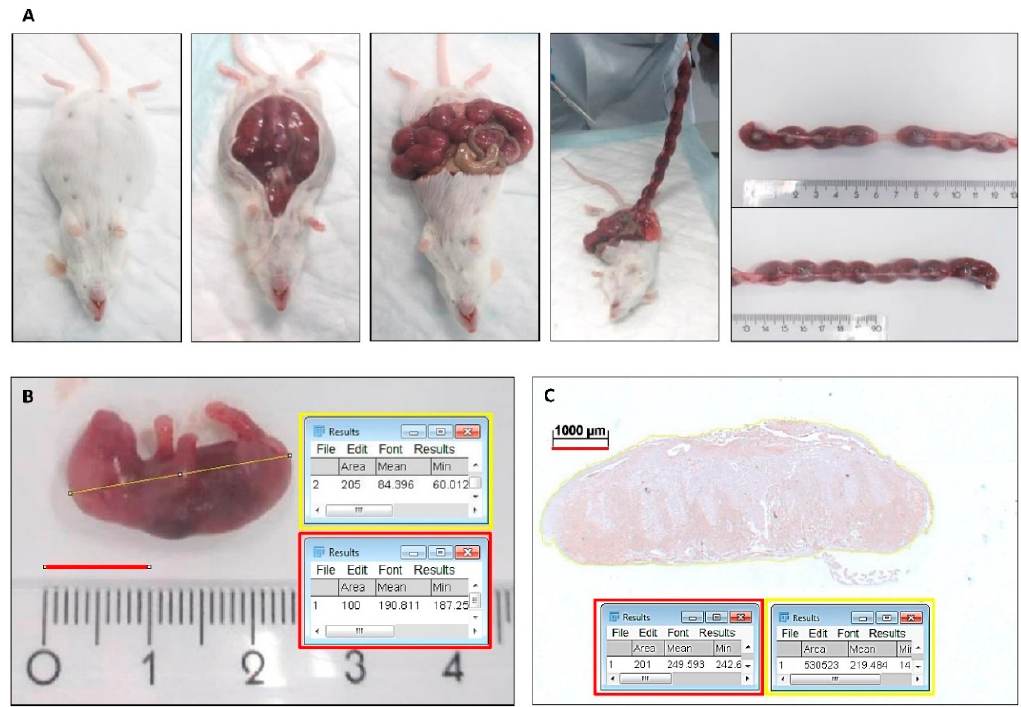
Figure 7. Isolation of fetuses and placentas and measurement of fetal body length and placental section surface area. ( A ) After sacrifice of the plugged mice at Day E16, the uteri were isolated (centimeter ruler). ( B ) The fetuses were separated from the placentas, photographed and a scale bar was drawn at the centimeter ruler of 10 mm, and the total number of pixels of the bar was determined (e.g., 30H; 100 pixels). A line depicting the length of the body of the fetus was drawn and the number of pixels was recorded (e.g., 205 pixels). The body length was calculated (e.g., 205/100 = 2.05 cm). ( C ) Placental sections surface area measurement. Coronal sections through the middle of the placenta (e.g., SnMP and ICAM-1 immunostaining). A scale bar was drawn at the ruler in each photograph of 1000 μ m × 1000 μ m (1 mm 2 ) included the total number of 40,401 (201 × 201) pixels. The outline of the